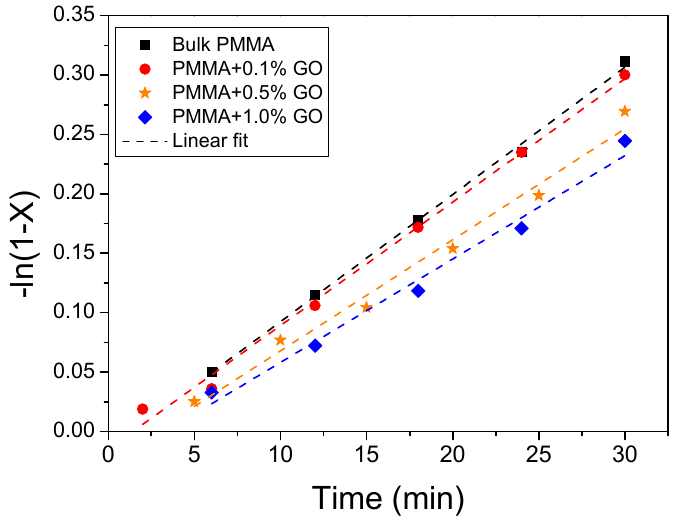
Figure 5. Estimation of the effective rate constant from plots of –ln(1 − X ) versus time according to Equation (2) for the neat PMMA and PMMA/GO nanocomposites with different relative amounts of GO obtained from in situ polymerization at 80 °C with a 0.03 mol/L initial initiator concentration in bulk.